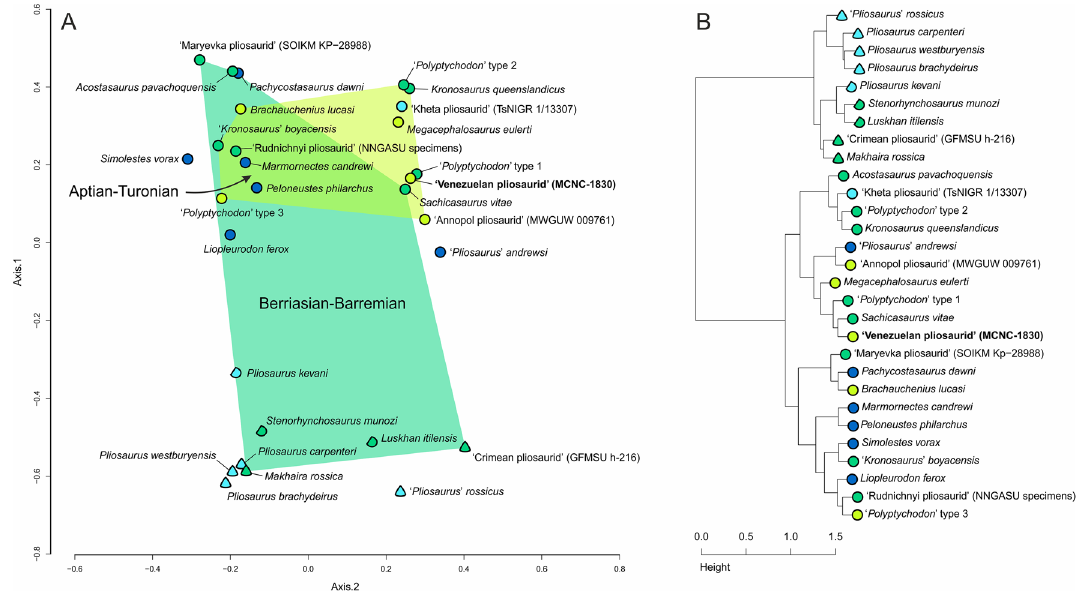
Figure 4. Results of the principal coordinates analysis ( A ), showing the morphospace occupation of MCNC- 1830 among Jurassic and Cretaceous pliosaurids, using principal coordinates 1 and 2, and results of the cluster analysis ( B ). Graphic representation and color scheme of the results follow 5 : circles—crowns with subcircular cross-section; semicircles—crowns with subtriangular cross-section; triangles—crowns with approximately triangular cross-sections. Graphic results exported from RStudio Version 1.2.5033 77 ; figure created by Daniel Madzia using CorelDraw X8